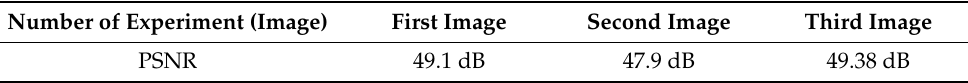
Table 1. The PSNR values obtained for each studied